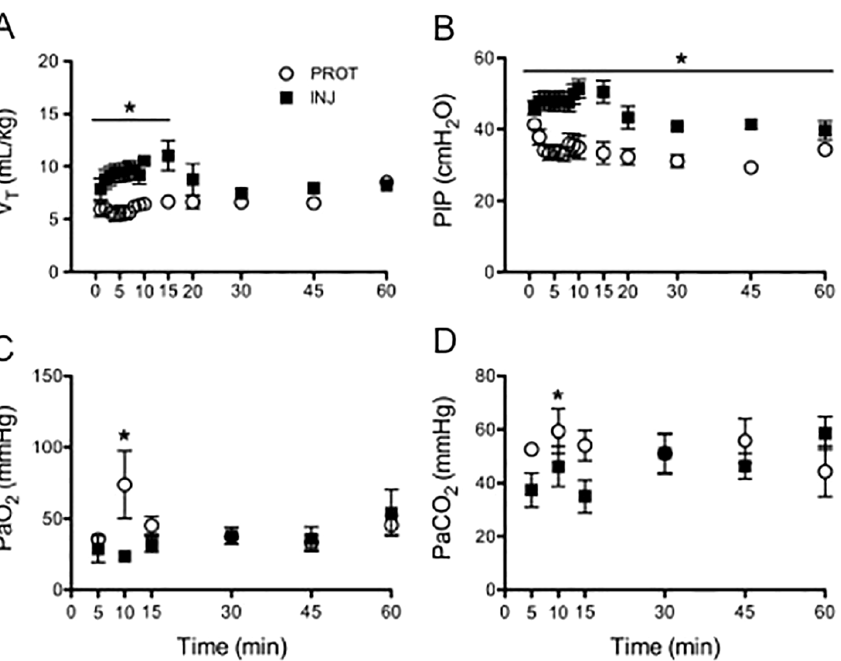
Figure 3. Ventilation and oxygenation. Ventilation and arterial blood gas measurements in lambs ventilated with an injurious strategy (black squares) versus a protective strategy (open circles) during the first 15 minutes, followed by maintenance ventilation until 1 hour. A) Tidal volume (V T ; Group: p=0.002, F=19.14; Time: p=0.58, F=0.87; Group 6 Time: p=0.17, F=1.42) B) Peak inspiratory pressure (PIP: Group: p=0.002, F=19.24; Time: p , 0.001, F=5.72; Group 6 Time: p=0.07, F=1.70) C partial pressure of arterial (Pa) oxygen (PaO 2 ; Group: p=0.87, F=0.03; Time: p=0.13, F=1.6;